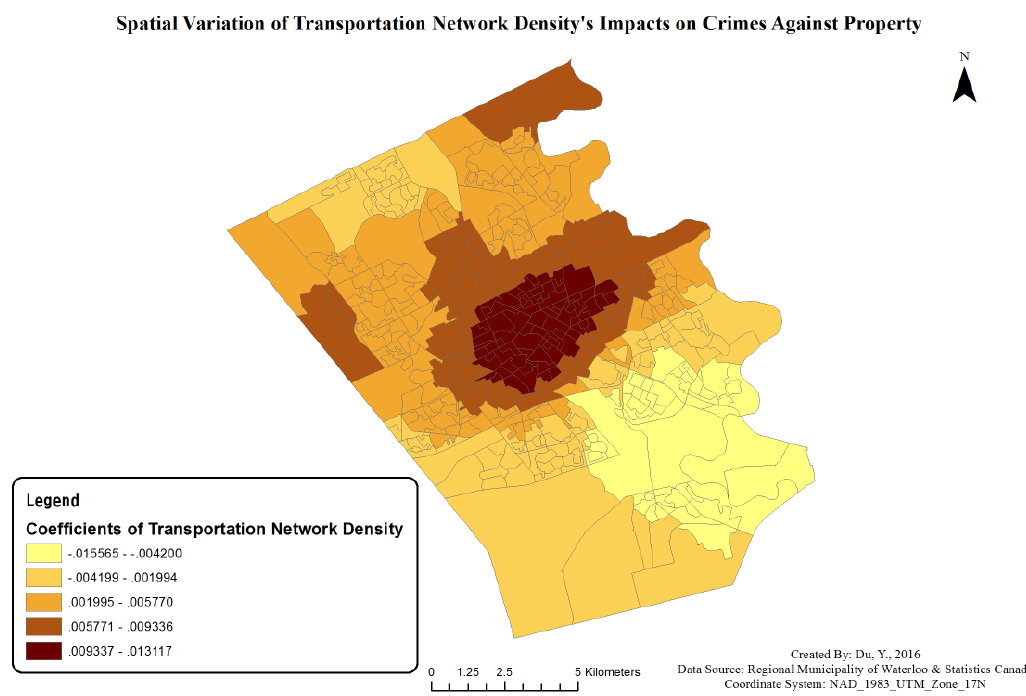
Figure 7. Transportation network density’s impact on crimes against property.